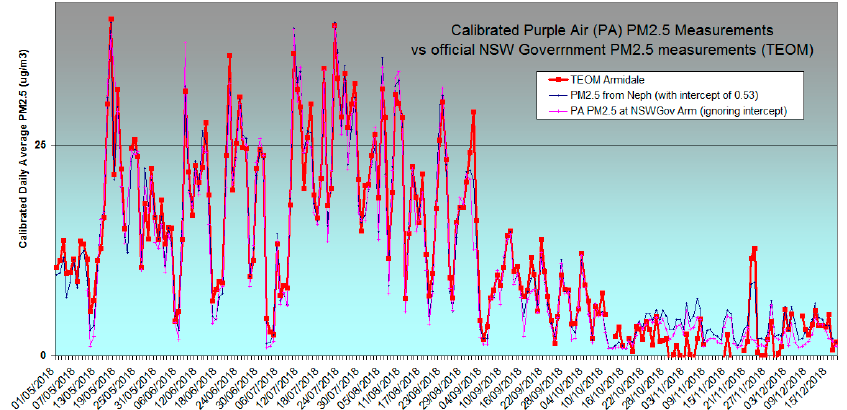
Figure A1. Comparison of calibrated nephelometer and PurpleAir PM 2.5 measurements with NSW government tapered element oscillating microbalance (TEOM) PM 2.5 measurements, Armidale 2018.